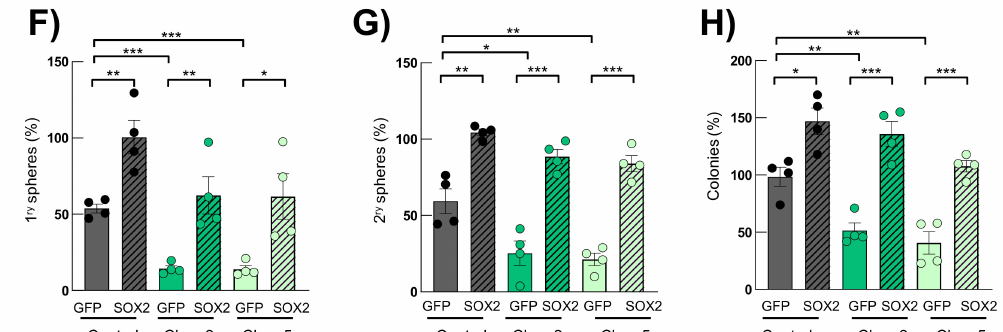
Figure 4. SOX2 overexpression rescues SOX2 expression and malignant properties in SRR2 -deleted cells. ( A ) Representative images of SOX2 immunofluorescence (scale bar = 50 µ m) and ( B ) quantification of SOX2-positive cells in U373MG control, SRR2 del clone2 and clone5 cells infected with control (GFP) and SOX2 (SOX2) constructs ( n = 4). ( C ) Representative immunoblot of SOX2 in GFP control, clone2 and clone5 cells in GFP and SOX2 cells ( n = 3). ( D ) Cell growth curve performed in GFP and SOX2 cells of indicated genotypes and time points ( n = 4). ( E ) Quantification of positive pH3 + cells in GFP- and SOX2 -overexpressing cells ( n = 4). ( F , G ) Quantification of primary and secondary oncospheres in GFP- and SOX2 -overexpressing cells ( n = 4). ( H ) Quantification of colony in indicated genotypes after 10 days in culture ( n = 4). The statistical significance was obtained with the Student’s t -test (* p < 0.05, ** p < 0.01 and *** p <